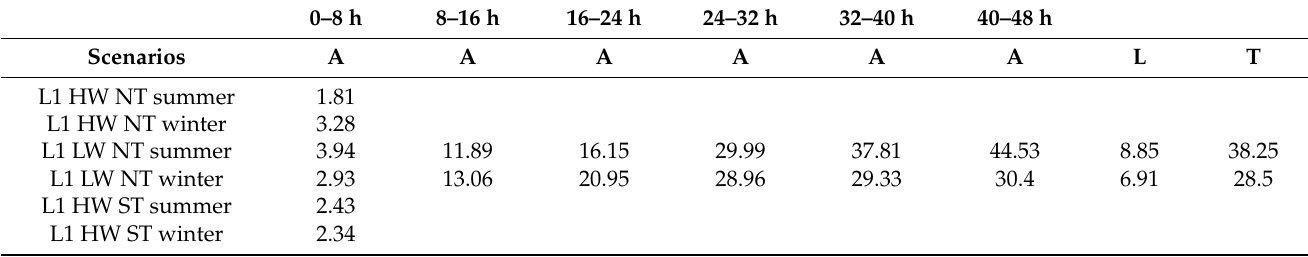
Figure 4. Simulated trajectories of oil released to the Humber Estuary under different scenarios. L1, L2 = release points; HW = high water; LW = low water; NT = neap tide; ST = spring tide. Note: Figure 4c is the same as shown in detail in Figure S5. Table 5. Simulated oil slick impacted area, A (sq. km), length of estuary bank line polluted, L (km), and oil travel time to reach estuary bank, T (hours), for different seasonal flow